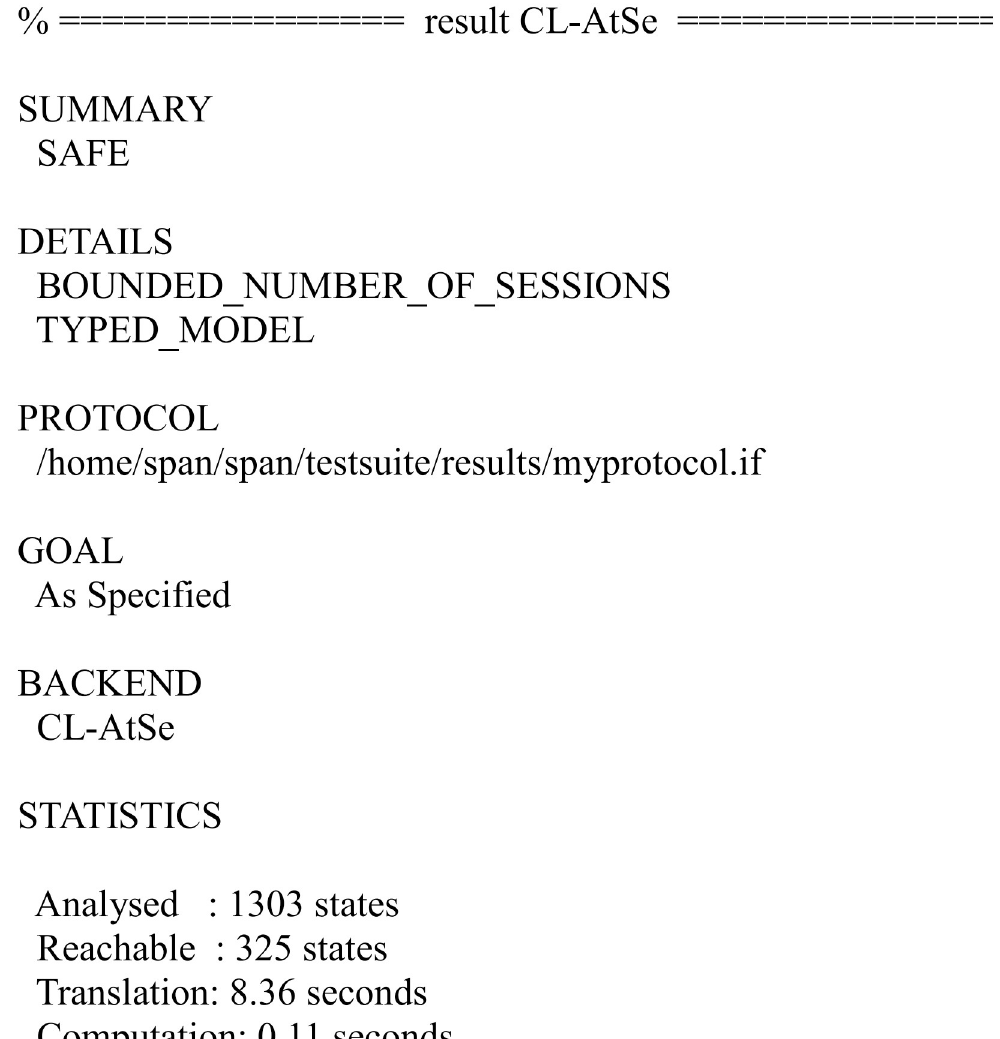
Fig 11. The result of the analysis using CL-AtSe